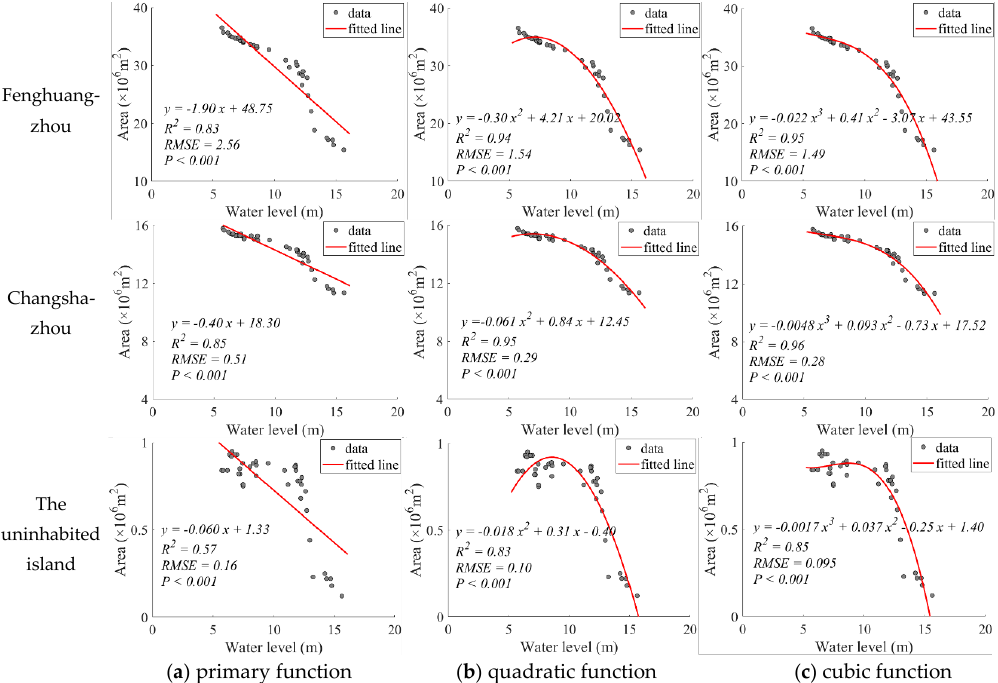
Figure 5. Relationships between the area of river islands and the water level of Datong hydrological stations.